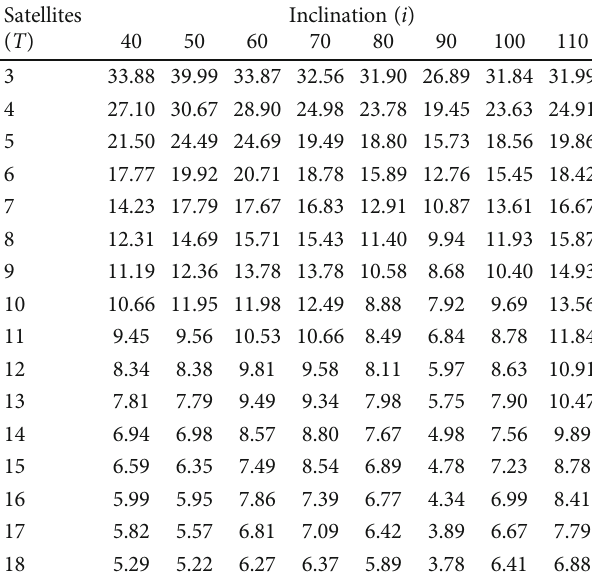
Table 3: θ requirement for the COF method.